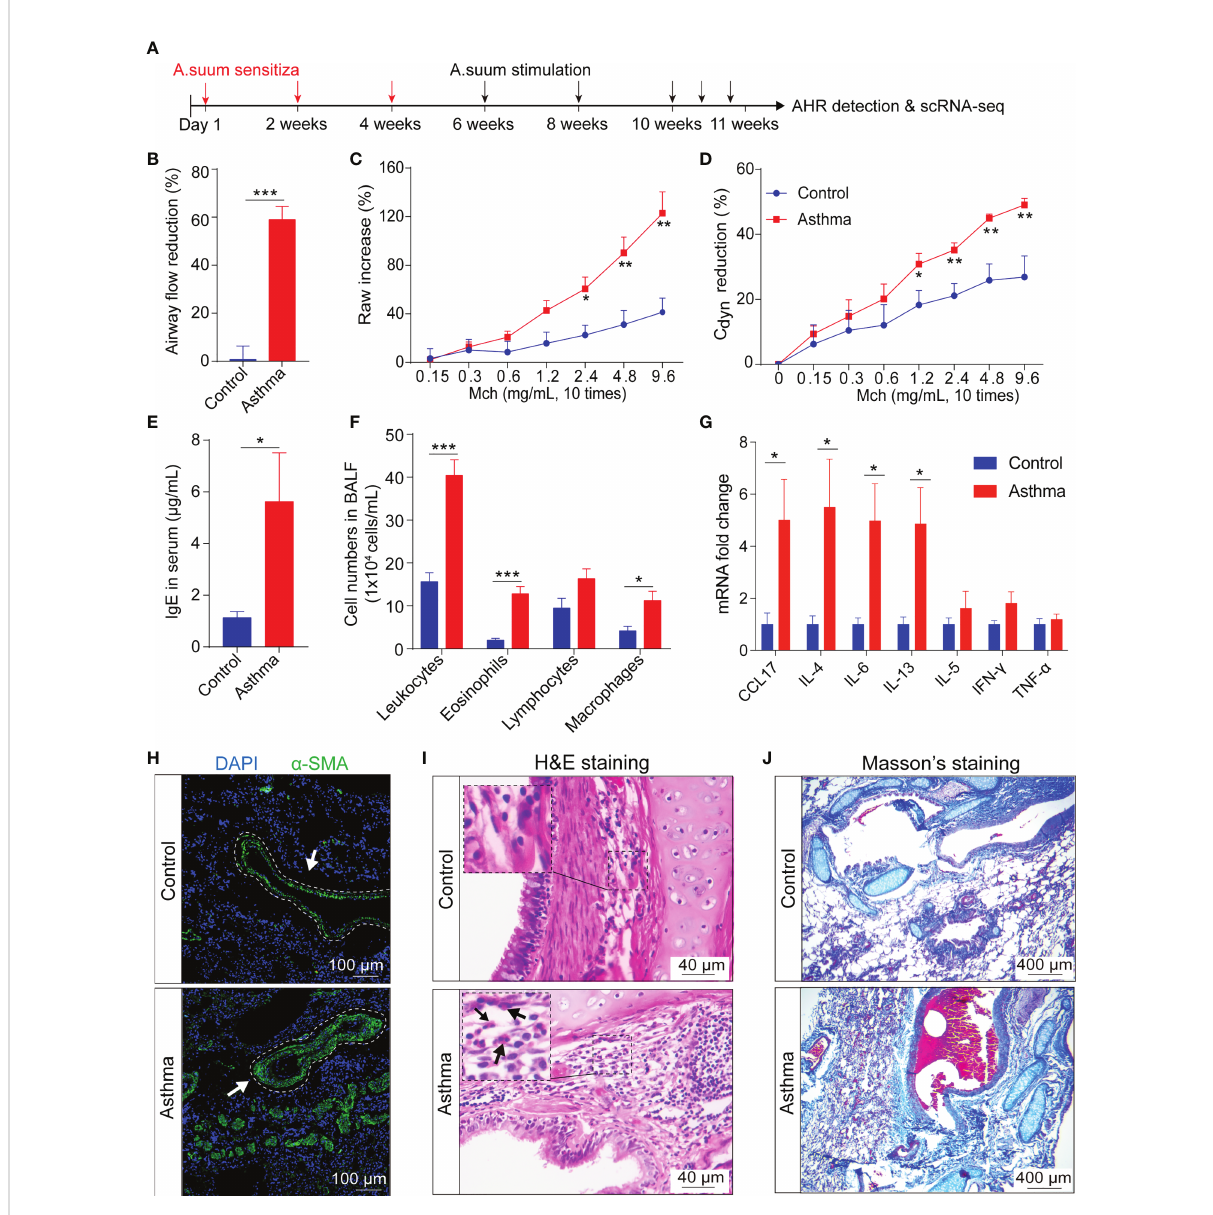
FIGURE 2 A.suum induced asthma results in airway hyperresponsiveness and airway remodeling in cynomolgus monkeys. (A) , The experimental design is shown. Lung tissues were collected following AHR assessments. (B, D), Airway hyperresponsiveness, including airway fl ow reduction (B) , raw increased (C) and cdyn reduction were detected in the asthma group. (D-F) , Asthma signi fi cantly increases the concentration of IgE (E) and the number of leukocytes, lymphocytes, eosinophils and macrophages (F) in the BALF. (G) , Asthma signi fi cantly increases the gene expression related to in fl ammatory and immunological regulation in the lung compared to the control group. (H) , Representative immuno fl uorescence of interstitial myo fi broblast marker a -SMA (green) in airway epithelium, as indicated by white arrows. Scale bar, 100 m m. (I) , H&E staining shows in fi ltration of eosinophils in the airway submucosa. Scale bar, 40 m m. (J) , Masson ’ s staining shows collagen deposition in the lung. Scale bar, 400 m m. * p < 0.05, ** p < 0.01, *** p < 0.001, Student ’ s t-test. Data are presented as mean ±